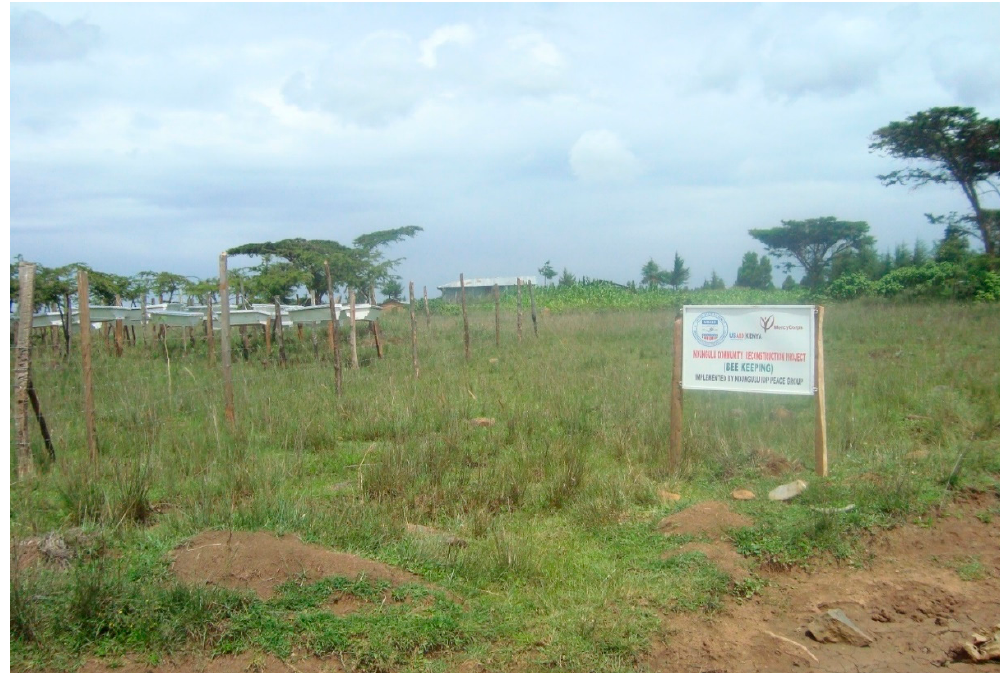
Figure 3. Bee-keeping 40 project on Ndungulu settlement scheme.